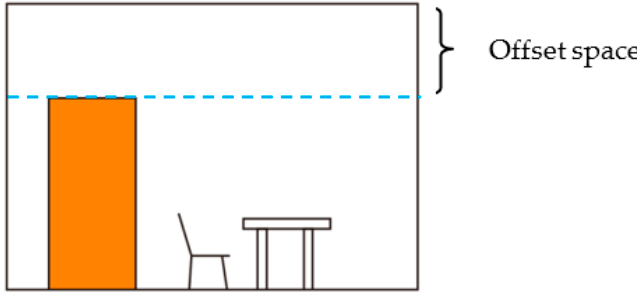
Figure 2. A point cloud split into a set of horizontal slices. ( a ) original point cloud; ( b ) sliced point cloud.